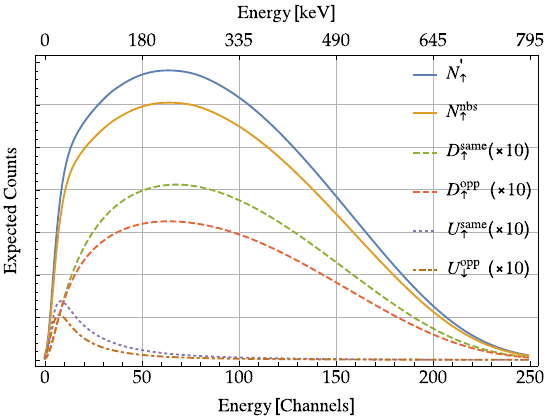
Figure 4. The individual components of the corrected number of counts N (cid:7) ↑ from Eq. (7), as calculated in Eq. (11). Spectra including backscattering are enhanced by a factor of 10. Undetected backscatter events U opp ↓ from the opposite detector are assigned to the wrong